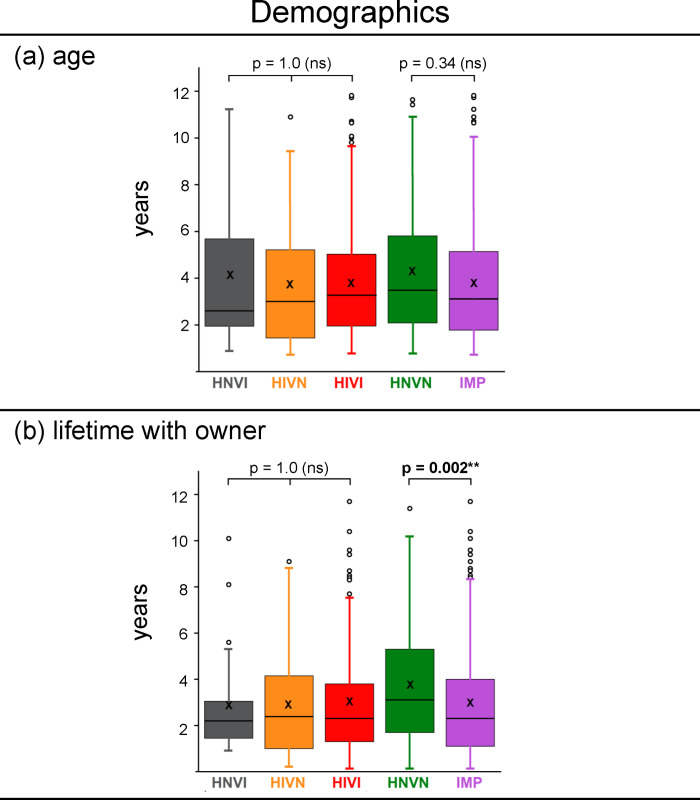
Box-plots of individual values of (a) age and (b) lifetime with owner for each group, and for the three sensory impaired groups gathered (IMP). HNVI = hearing normal vision impaired (grey), HIVN = hearing impaired vision normal (orange), HIVI = hearing impaired vision impaired (red), HNVN = hearing normal vision normal (green), IMP = impaired (purple), ns = non significant. The bold bar within the boxplot is the median, the cross is the mean, the bottom and top of the box are the lower and upper quartiles, respectively, and the dots are outlier values above the [upper quartile + 1.5 * inter-quartile distance] limit (top of upper vertical bars). Horizontal brackets indicate the two-by-two comparisons between groups that were statistically assessed using Shapiro-Wilk tests.